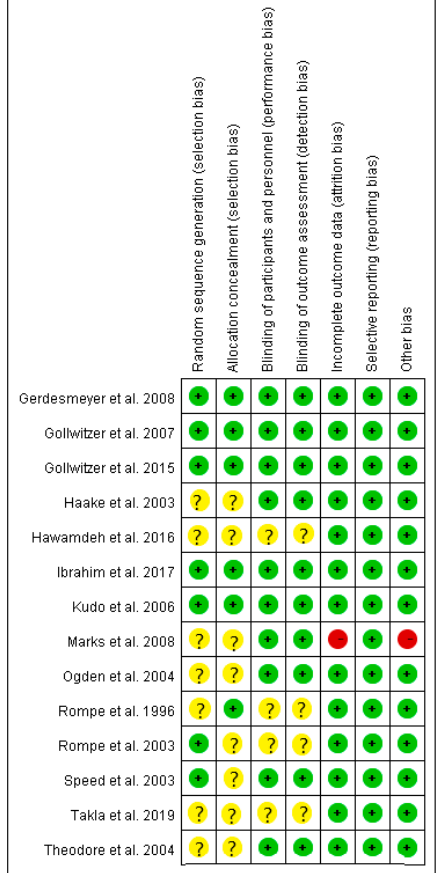
Figure 3. Risk of bias of each included article assessed by the two authors for each risk item. The symbol “+” indicates low risk, the symbol “?” indicates unclear risk, and the symbol “ − “ indicates high risk.